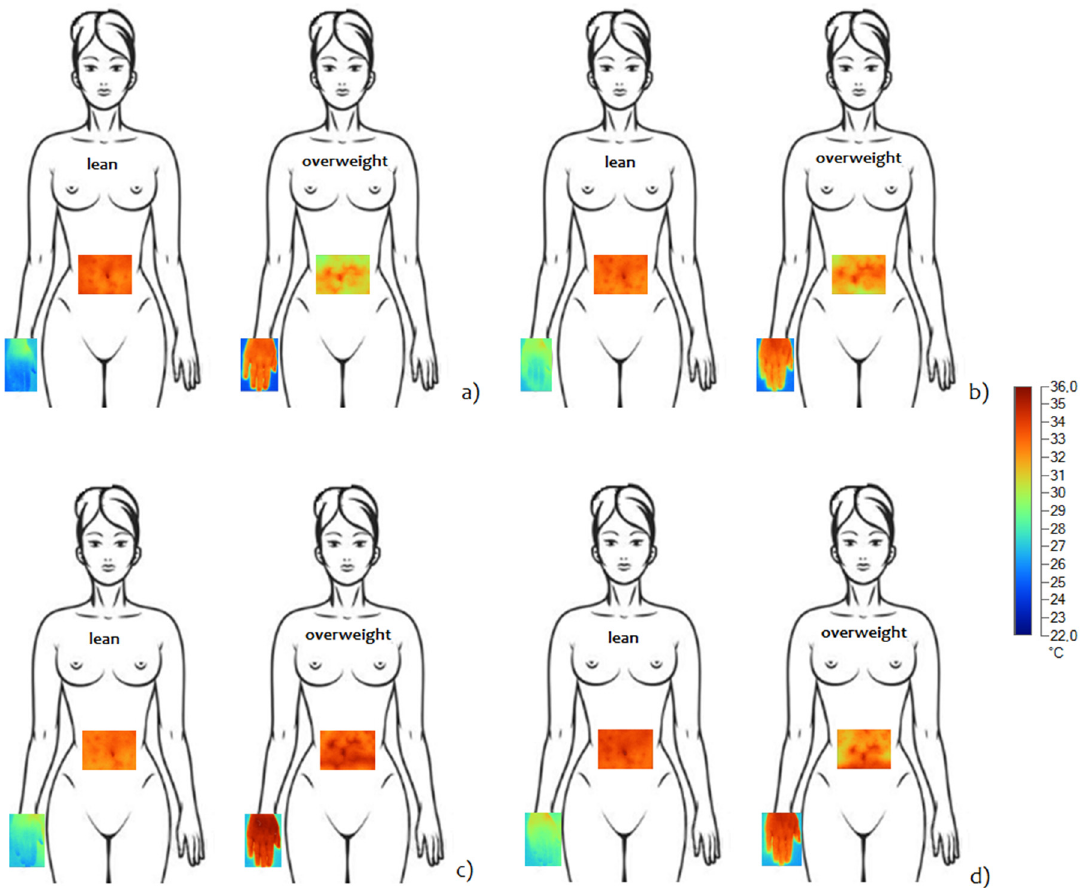
Figure 6. Abdominal and hand patterns of thermal response during OGTT for a lean subject and an overweight subject: ( a ) baseline condition, ( b ) 60 ′ after glucose ingestion, ( c ) 120 ′ after glucose ingestion, ( d ) 180 ′ after glucose ingestion.